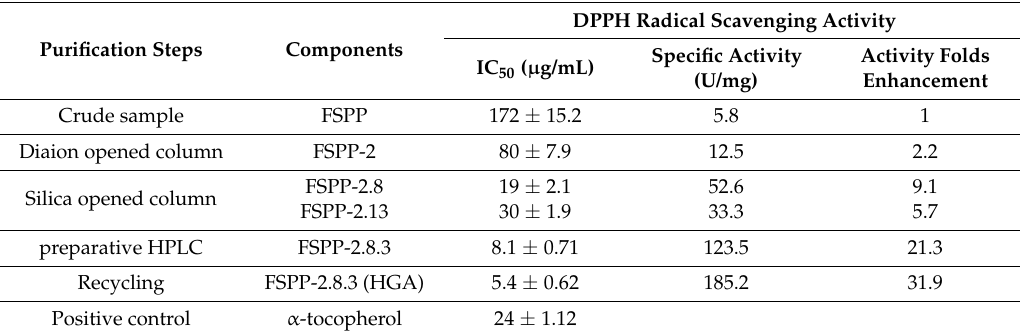
Table 2. Enhancement of activity after partial purification of